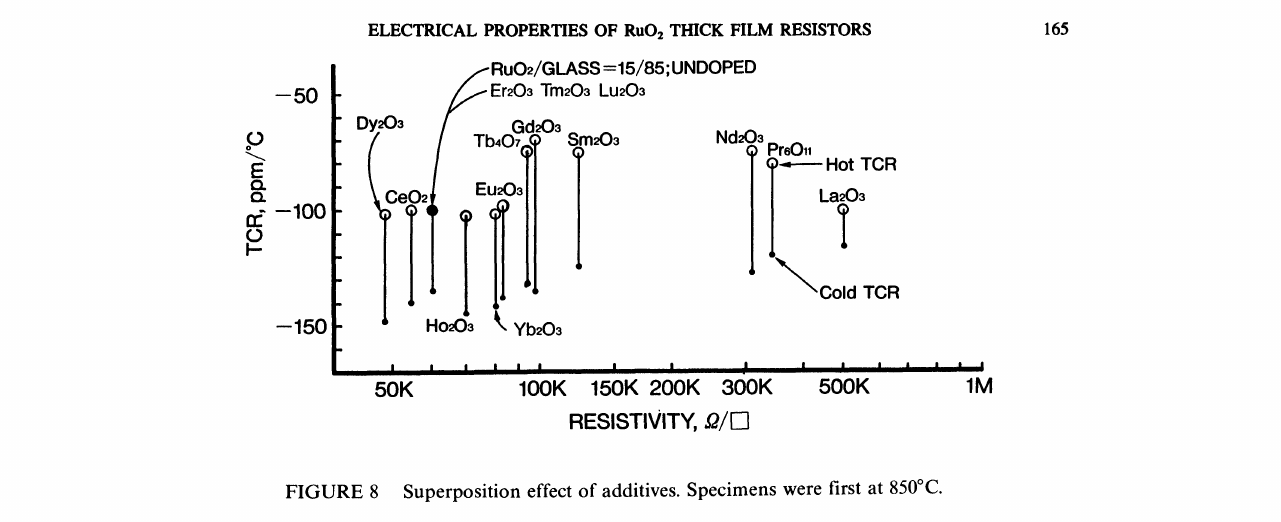
FIGURE 8 Superposition effect of additives. Specimens were first at